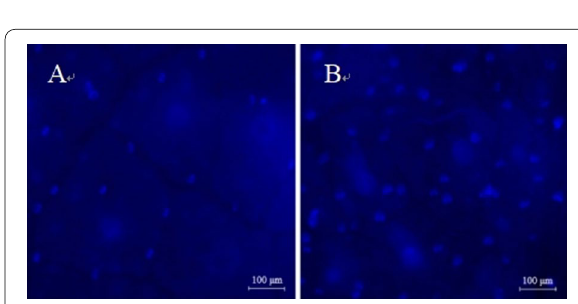
Fig. 7 EBS03 induced callose accumulation in cotton leaves. A control; B treated with